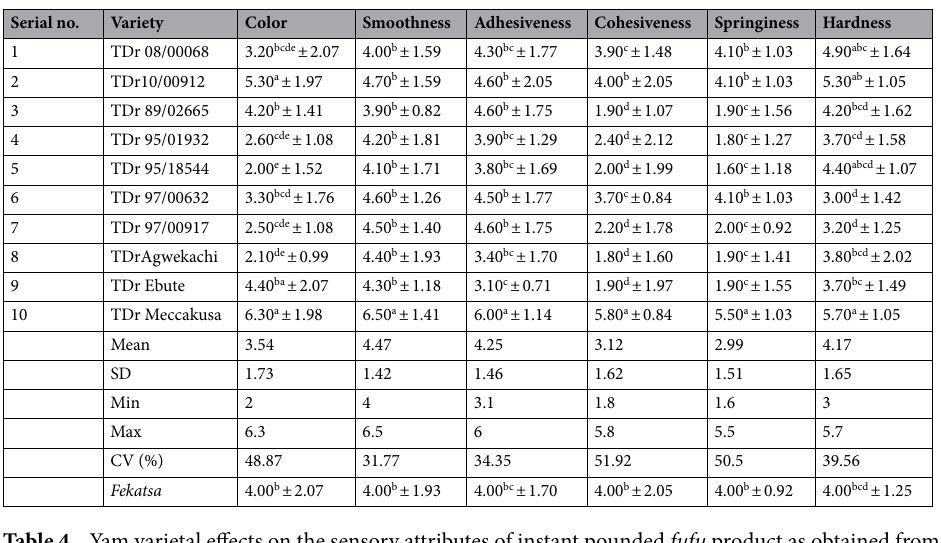
Table 4. Yam varietal effects on the sensory attributes of instant pounded fufu product as obtained from control and 10 improved varieties of Dioscorea rotundata. Values are means of 10 observations; Scale of 1 to 7, where 1 = very much worse, 2 = worse, 3 = slightly worse, 4 = no difference, 5 = slightly better, 6 = better, 7 = very much better compared to instant pounded yam from Fekatsa ( D. rotundata ) a Parameter mean value ± SD; Values with the same superscripts in the same column are not significantly different ( p > 0.05).